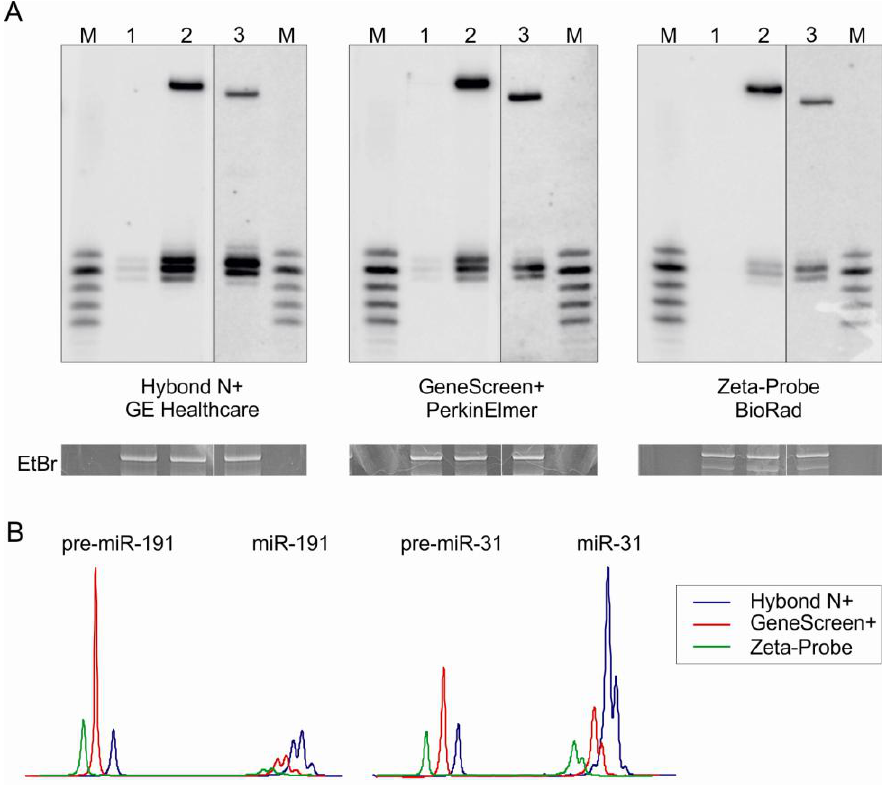
FIGURE 3. Transfer of RNAs: choice of membrane. (A) Hybridizations with probes complementary to miR-191 (lane 1 - endogenous expression, lane 2 - miRNA overexpressed from a vector) and miR-31 (lane 3 - overexpressed miRNA). Three different nylon membranes were used as indicated (see how one type of membrane is better for larger species, whereas the other performs better for the smaller species). M denotes a size marker; end-labeled 17-, 19-, 21-, 23-, and 25-nt synthetic ORNs. Staining with ethidium bromide (EtBr) provides a loading control. (B) Quantitative representations of the miRNA and pre-miRNA length variants are shown using peaks obtained from phosphorimaging analyses.